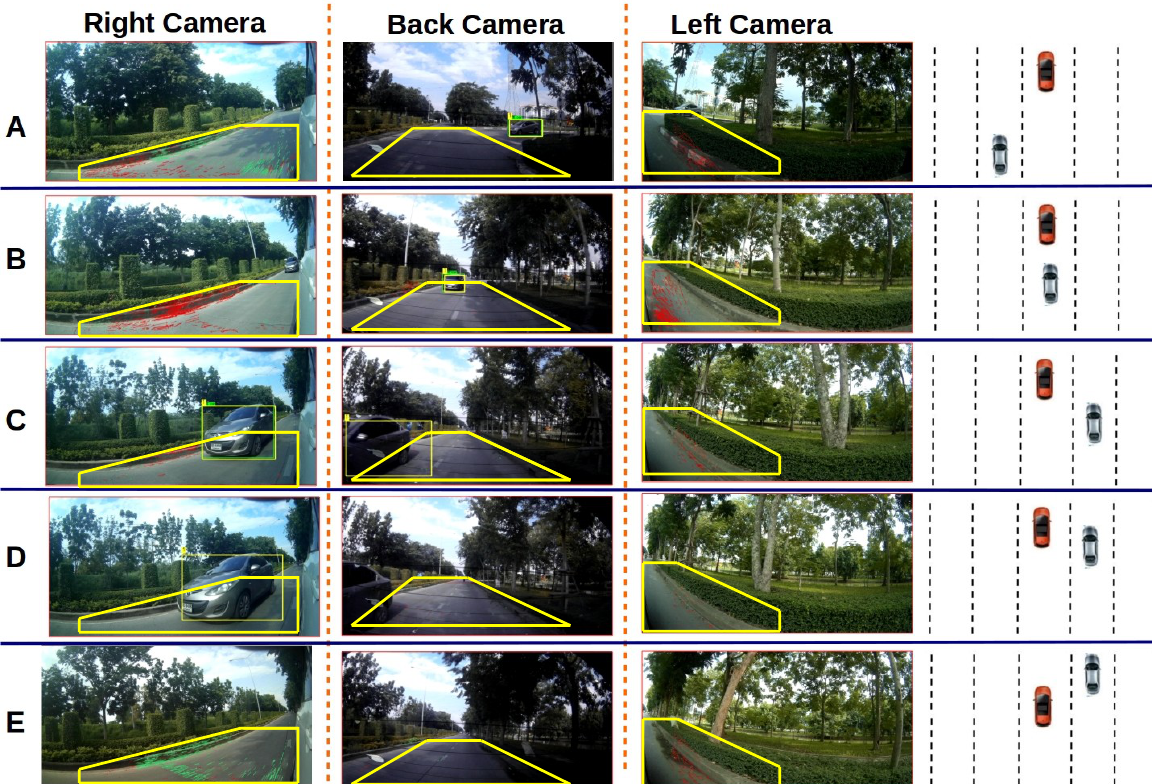
Figure 7. Experiment III (visual tracking evaluation) results. Row ( A ): example images in which a vehicle is detected and tracked by the back-side camera. This target was also visible in the left-side view but was not detected. Row ( B ): example images acquired when the vehicle exits the left-side camera view and enters the right-side and the back-side cameras views. This target vehicle was tracked in the back-side camera. Row ( C ): example images acquired as the vehicle moves from the back-side view to the right-side camera view. This vehicle was detected in frame 259 in the right-side view. Switching to the right-side camera is successful. Row ( D ): example image set acquired after the target has exited the back-side view. This vehicle continues to be tracked by the right-side camera. Row ( E ): example image set in which the target has exited the field of view in the right camera. This vehicle was mis-detected in the backward camera at frames 234, 235, and 236. It was then re-detected and tracked